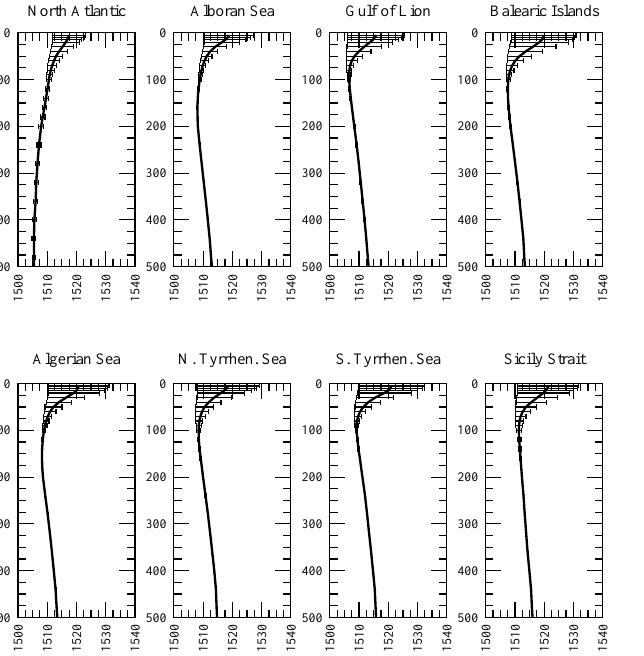
Fig. 9. West Mediterranean: annual mean sound speed profile (m/s) and relative computed temporal standard deviation σ t between a 5 and 500m depth.